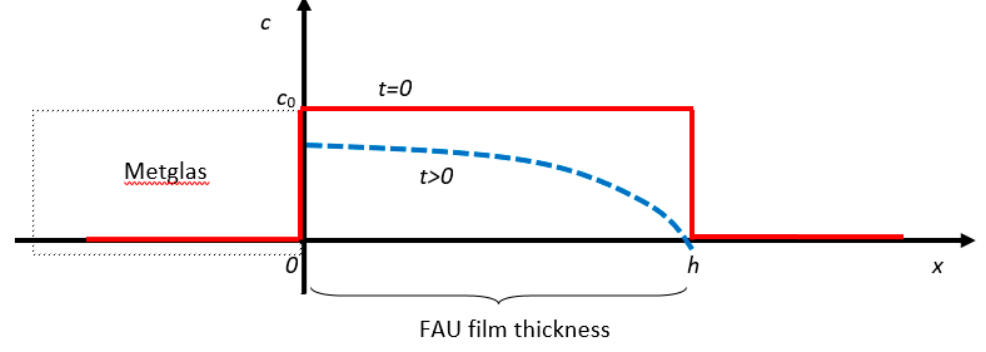
Figure A1. Initial and later gas concentration across the film thickness.